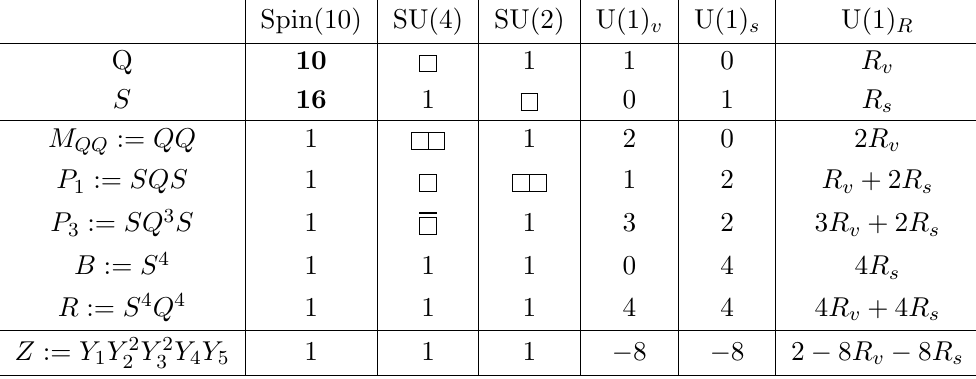
Table 11 . 3d N = 2 Spin(10) theory with ( N v ; N s ; N s 0 ) = (4 ; 2 ;